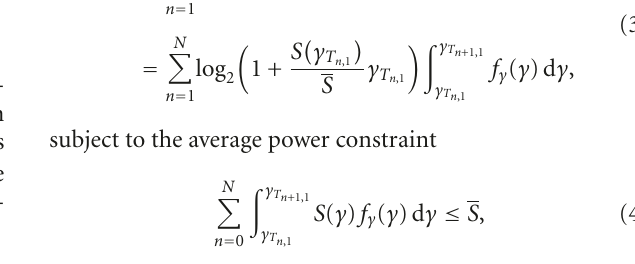
Figure 2: The pre-adaptation SNR range is partitioned into regions are the switching where γ T n , k